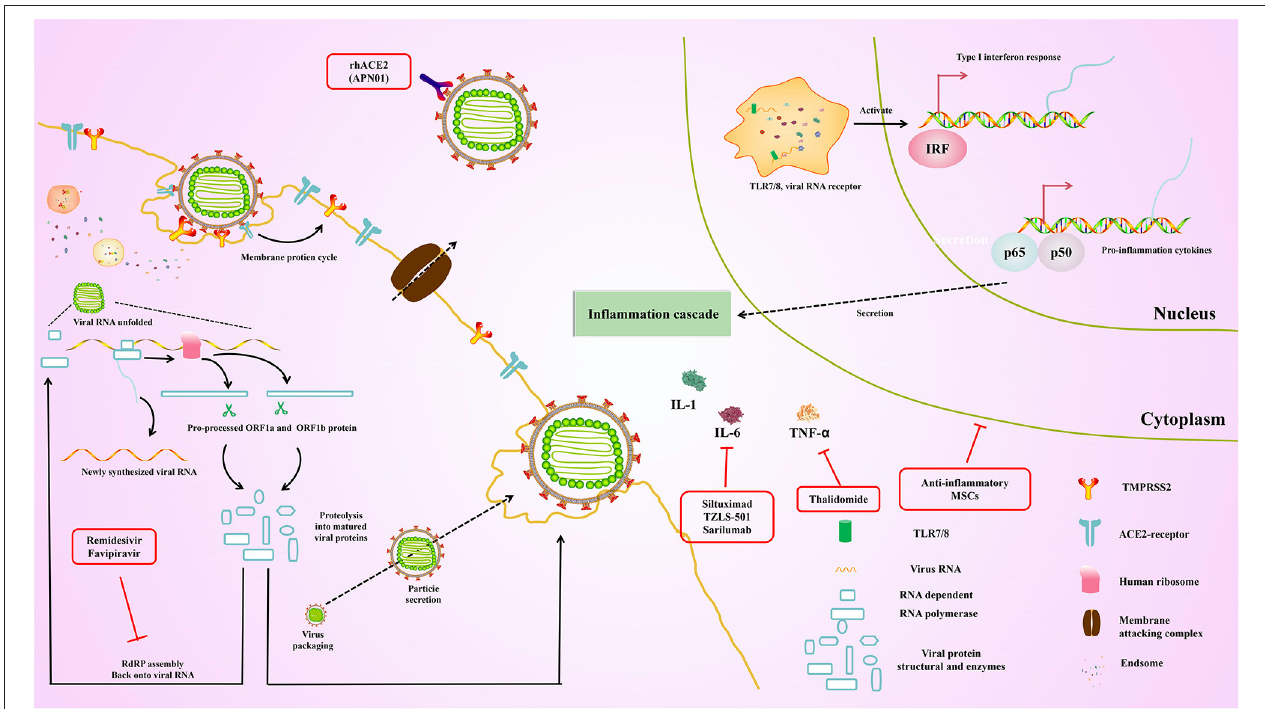
FIGURE 4 | Overview of the repurposed therapeutic drugs undergoing clinical trial against COVID-19 in the context of host pathways and virus replication mechanisms.